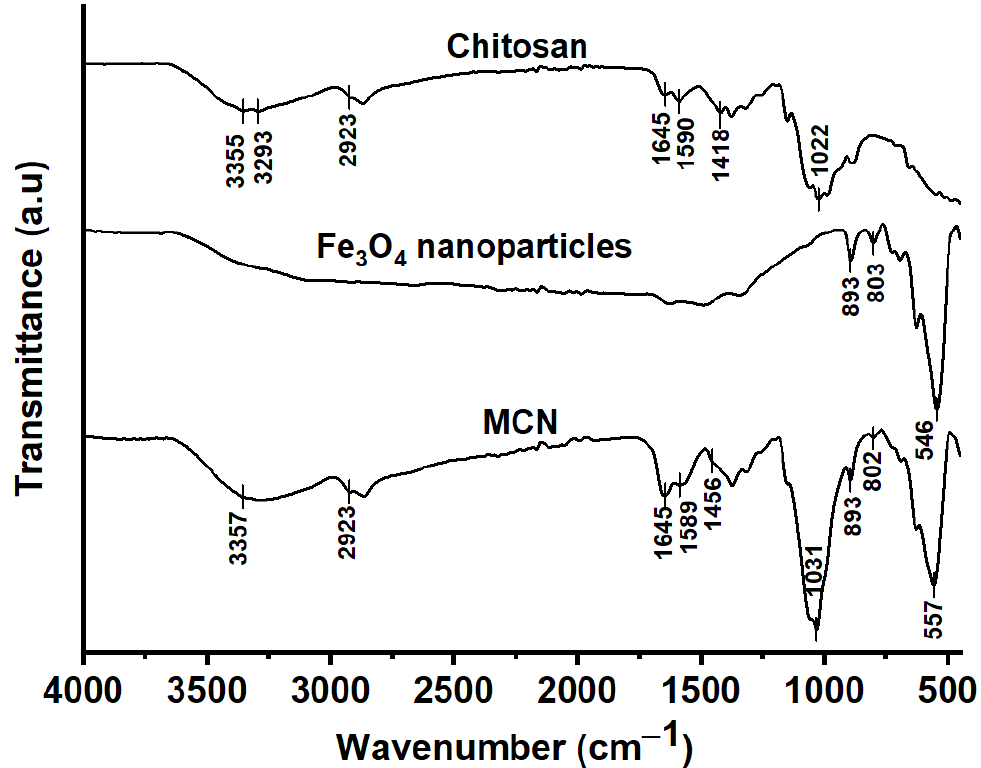
Figure 1. ATR-FTIR spectra of chitosan, Fe 3 O 4 nanoparticles, and MCN.